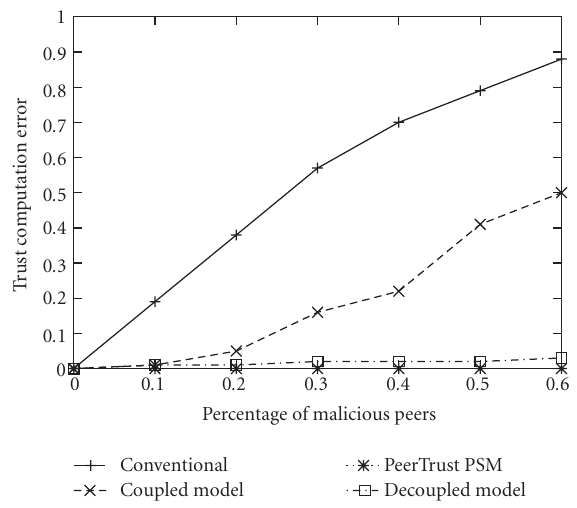
Figure 3: Trust computation error in a network with a varying per- centage of malicious peers.